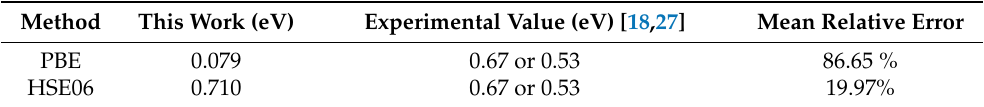
Table 3. The E g of CdGeAs 2 calculated by GGA–PBE and HSE06 methods. Method